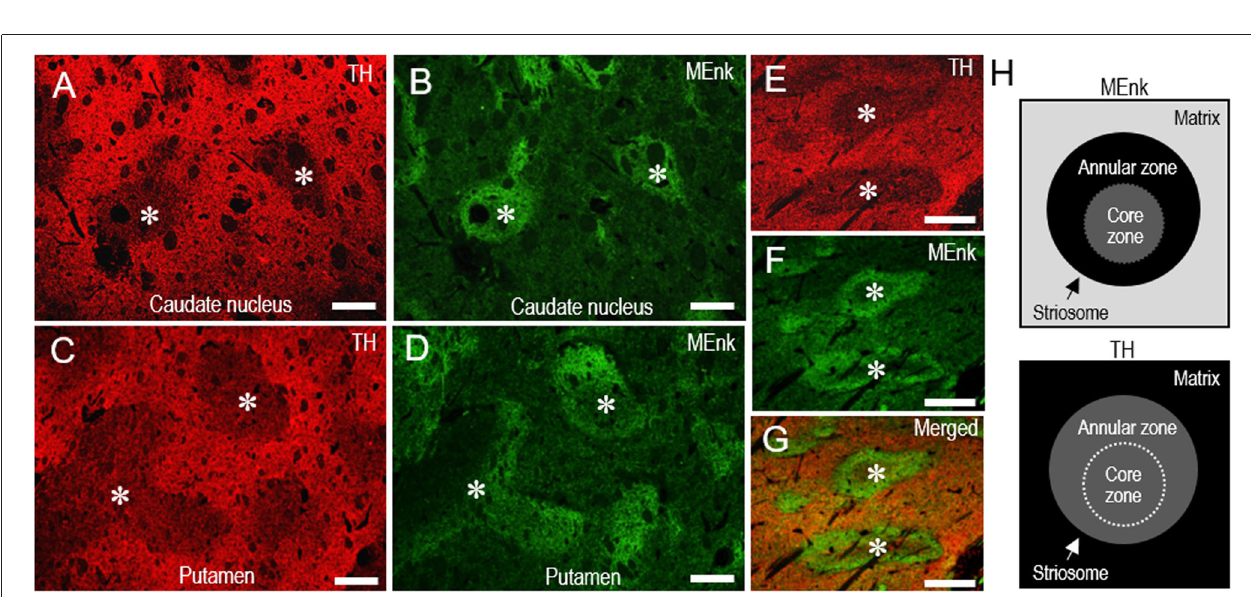
FIGURE 7 | Pattern of localization of TH in the striosome-matrix domains of the human neostriatum. (A–D) Photomicrographs of the CN (A,B) and putamen (C,D) double-stained for TH (A,C) and MEnk (B,D) . Corresponding striosomes are indicated by asterisks. (E–G) Photomicrographs of an area of the putamen double-stained for TH (E) and MEnk (F) , with a merged image (G) . Corresponding striosomes are indicated by asterisks. Note that the margins of the TH-poor zones correspond to the outer margins of the striosomes enriched in MEnk. (H) Depicted are the patterns of localization of MEnk ( upper ) or TH ( lower ) in the striosome-matrix system. The striosome consists of annular and core zones. Higher densities of TH or MEnk-immunoreactive products are indicated by higher gray-scale levels. Scale bars: (A–D) 500 µ m, (E–G) 250 µ m.